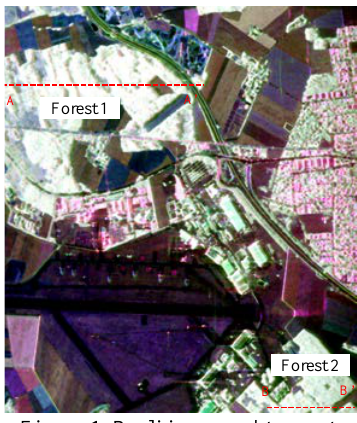
Figure. 1. Pauli image and transects